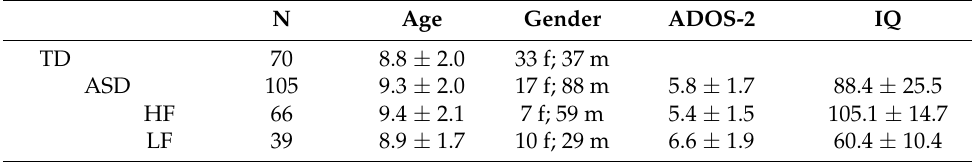
Table 1. Clinical and demographic features of